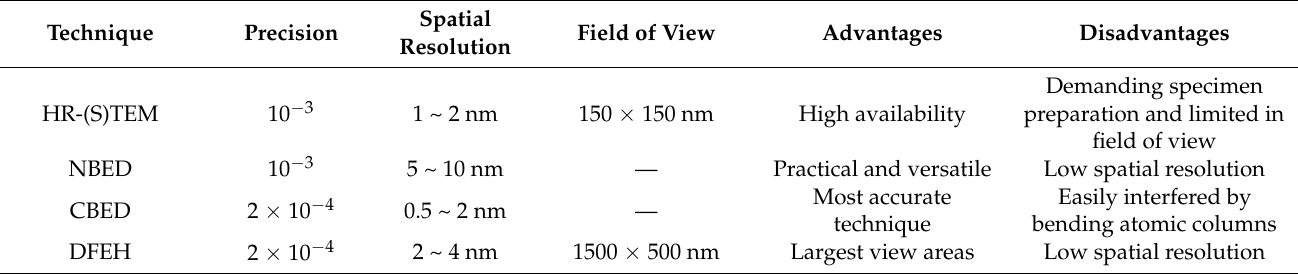
Table 1. Comparison of TEM strain measurement